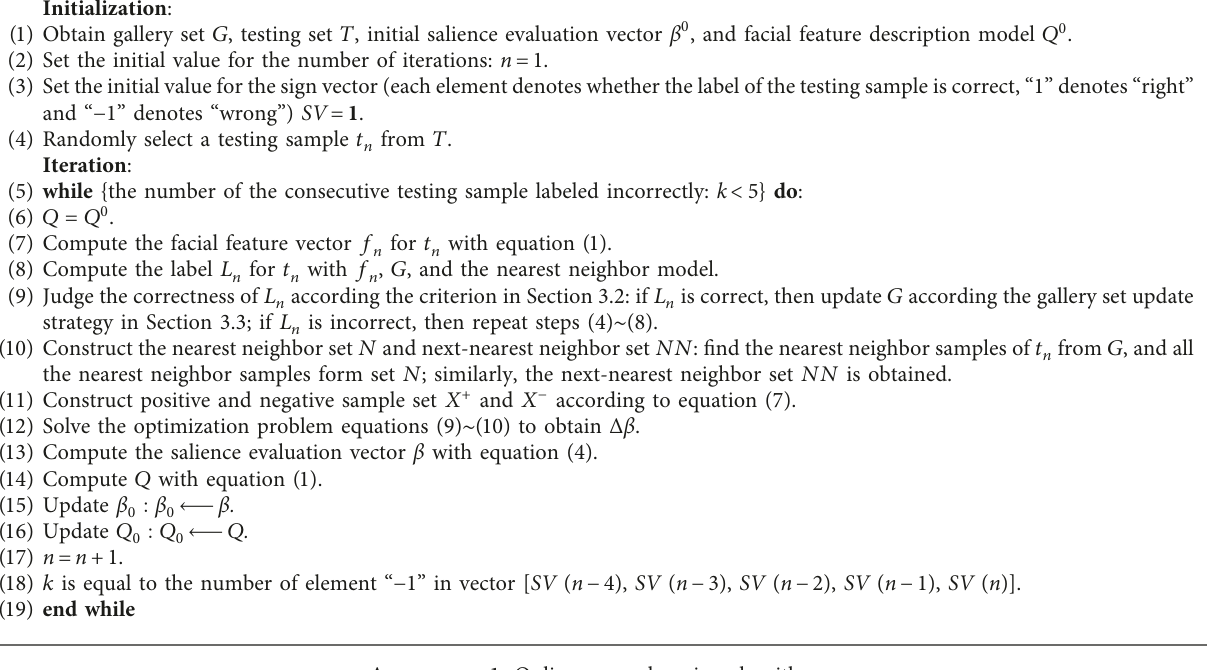
A LGORITHM 1: Online sparse learning